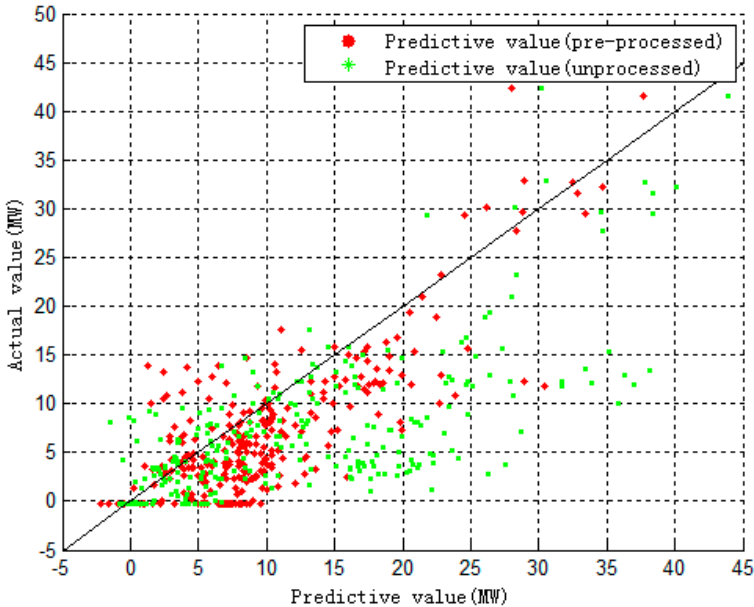
Figure 11. The degree of fit between the predictive values and the actual values.